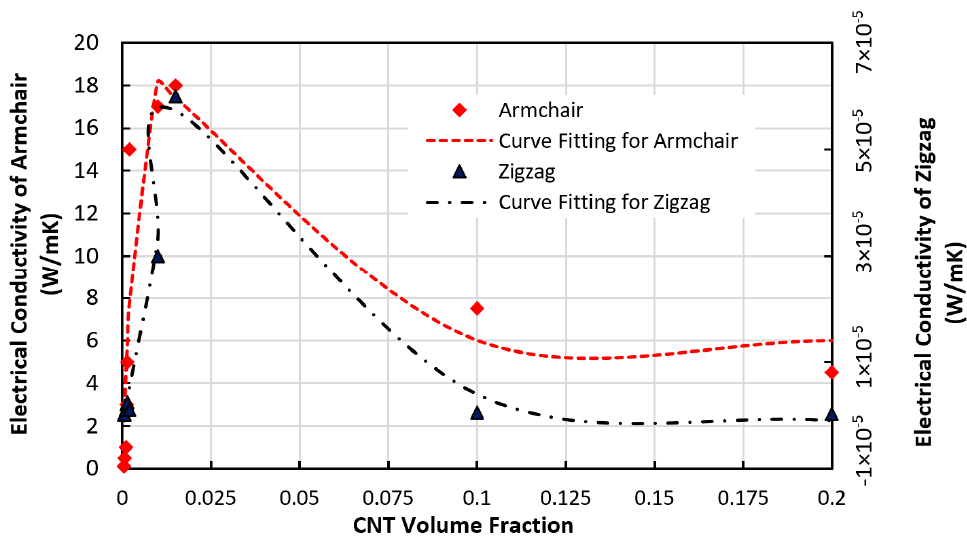
Figure 5. Electrical conductivities of armchair and zigzag SWNTs vs. CNT volume fraction in a composite with aspect ratios ranging from 7.5 × 10 3 to 15 × 10 3 [68,70]. Table 2. The electrical conductivities of armchair and zigzag SWNTs with di ff erent volume fractions of CNTs in a composite with an aspect ratio ranging from 7.5 × 10 3 to 15 × 10 3 , and with di ff erent lengths at a volume fraction of 0.0005 and a diameter of 1–2 nm [66,70].